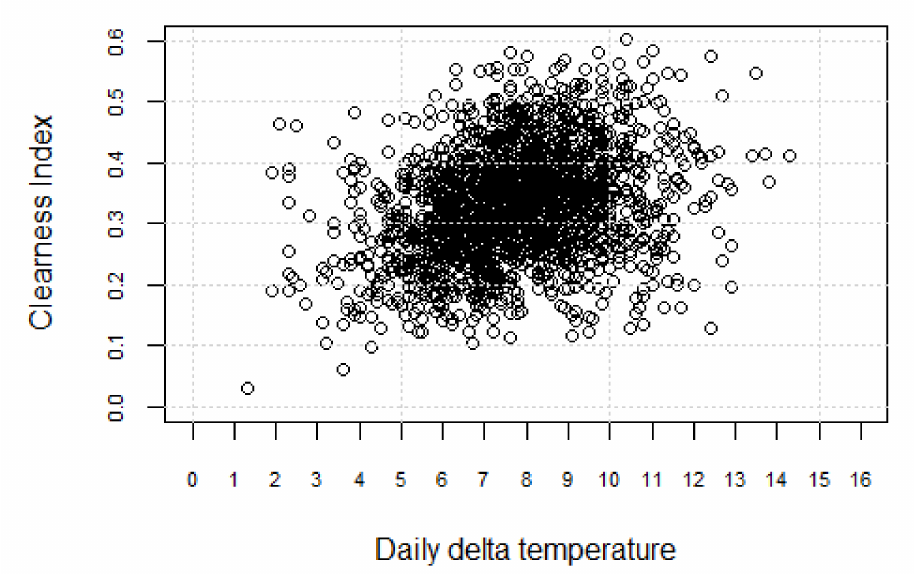
Figure 9. Daily delta of temperature–clearness index for